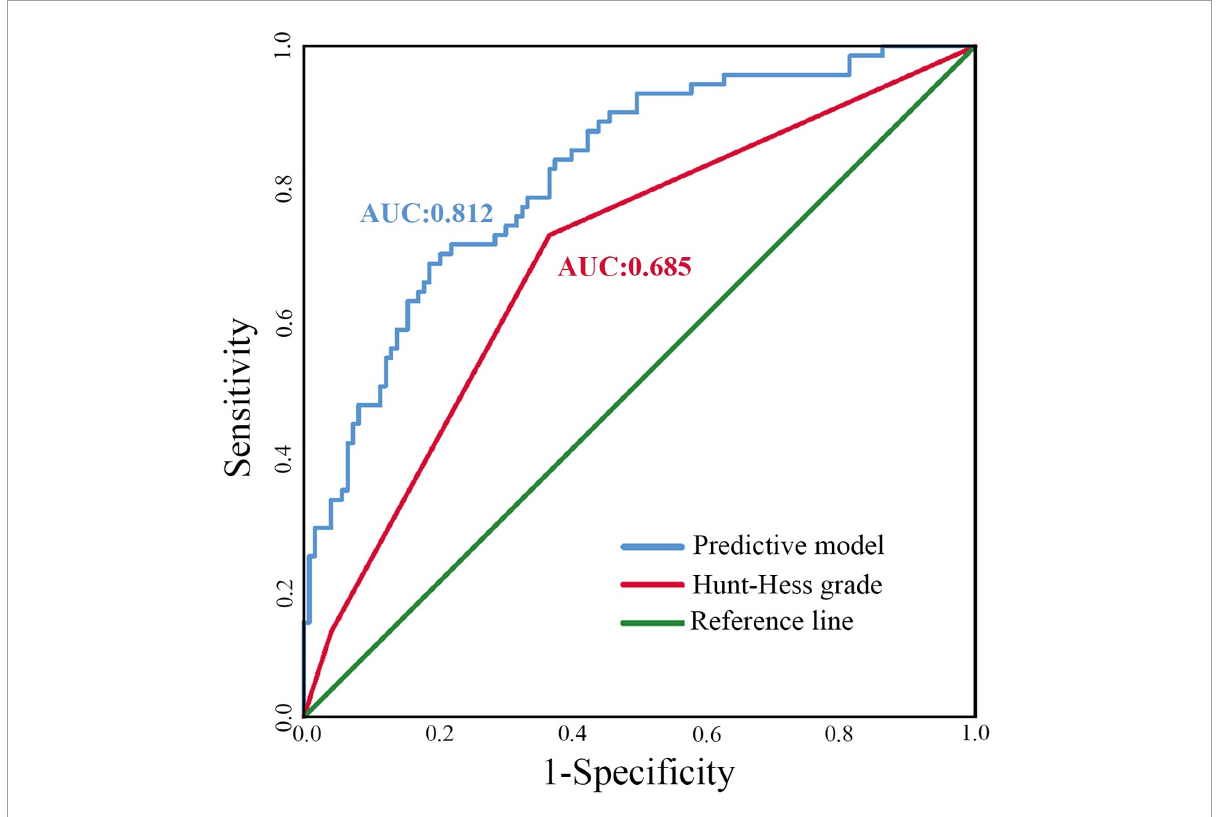
FIGURE2 The ROC curves for the different predictive models. AUC, area under the